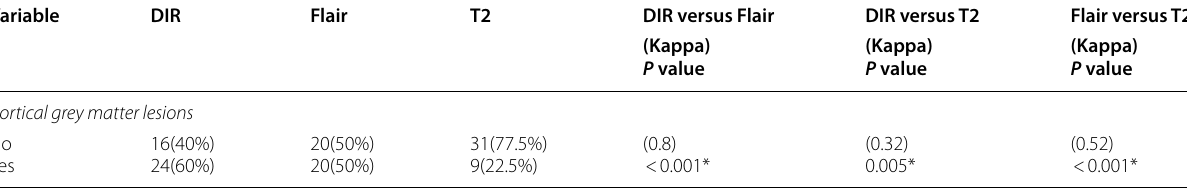
Significant level at P value < 0.05